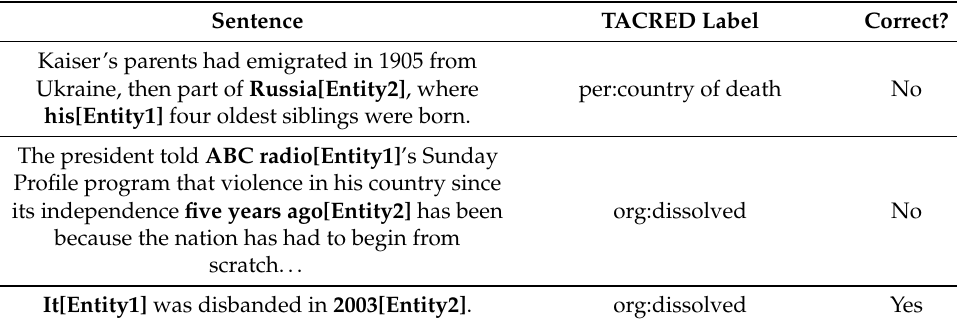
Table 2. Examples of traininig dataset from TACRED. The relation between [Entity1] and [Entity2] is annotated as shown in the TACRED label